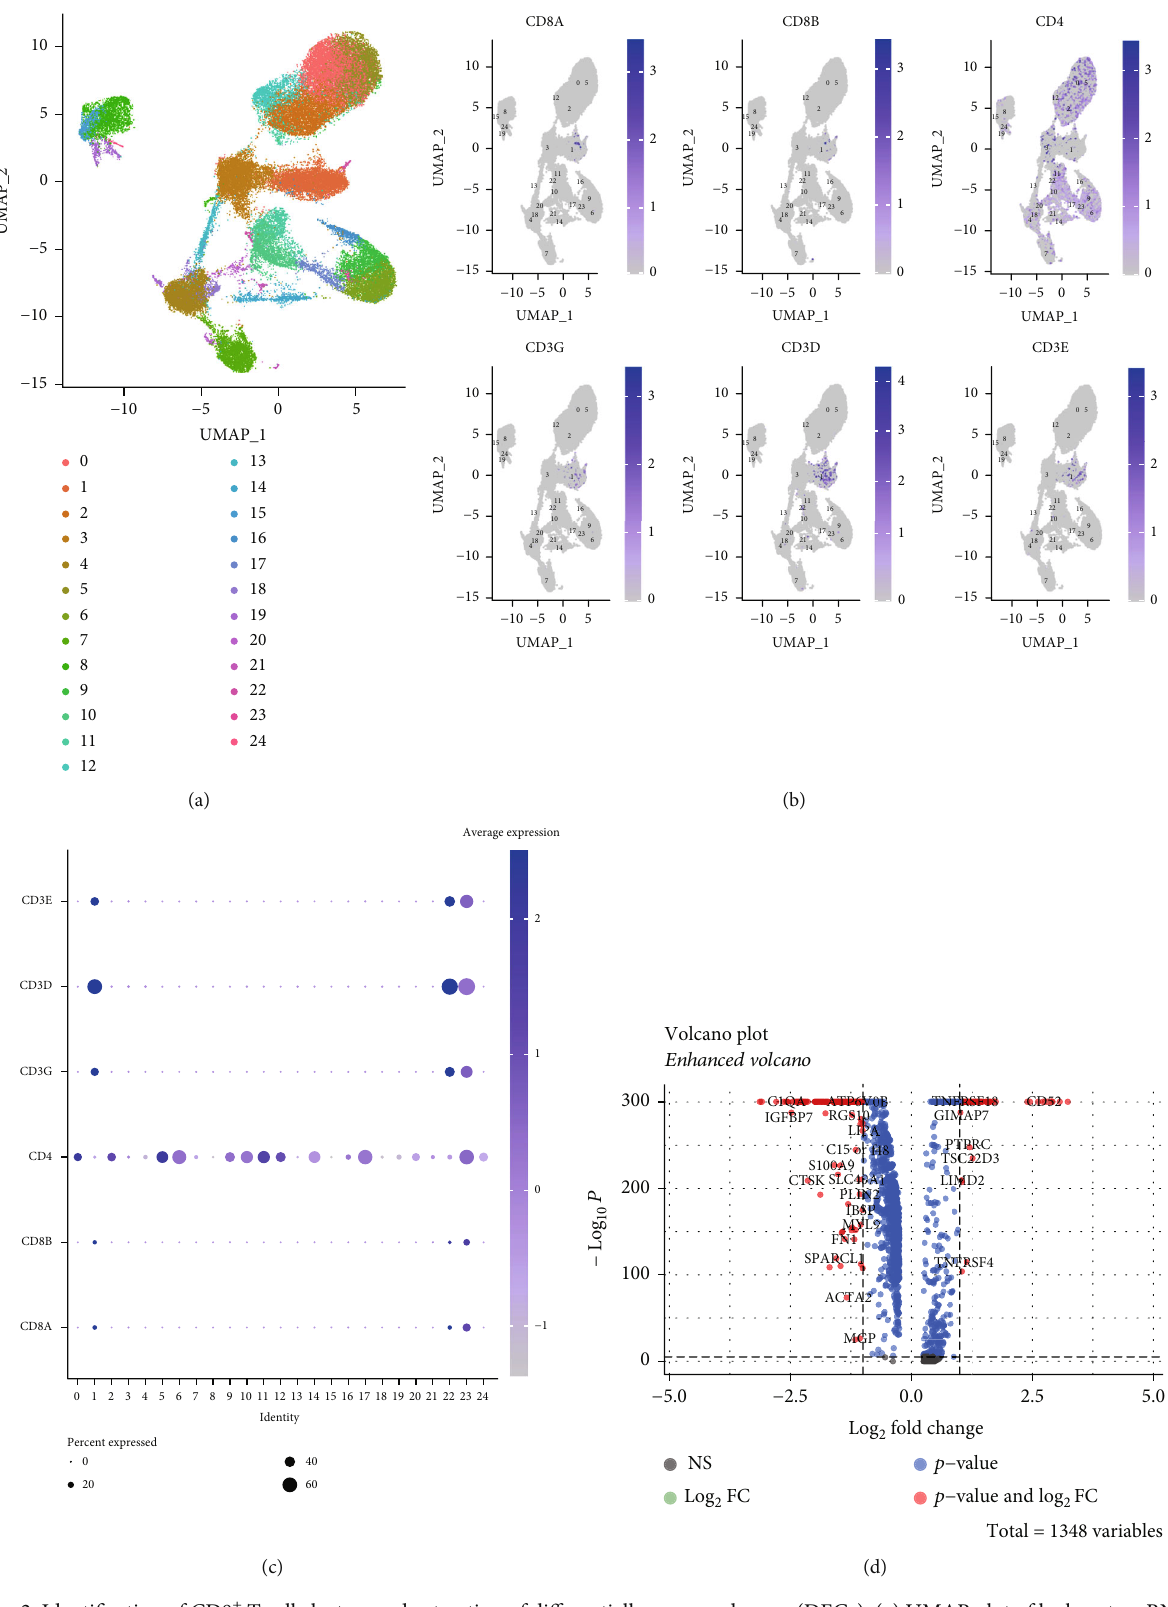
Figure 2: Identi fi cation of CD8 + T cell clusters and extraction of di ff erentially expressed genes (DEGs). (a) UMAP plot of leukocyte scRNA- seq data with 25 clusters. (b) UMAP plots of single-cell expression levels of di ff erent marker genes. (c) Expression of di ff erent marker genes in immune cell subsets. (d) Analysis of DEGs between the 1st subset of immune cells and other